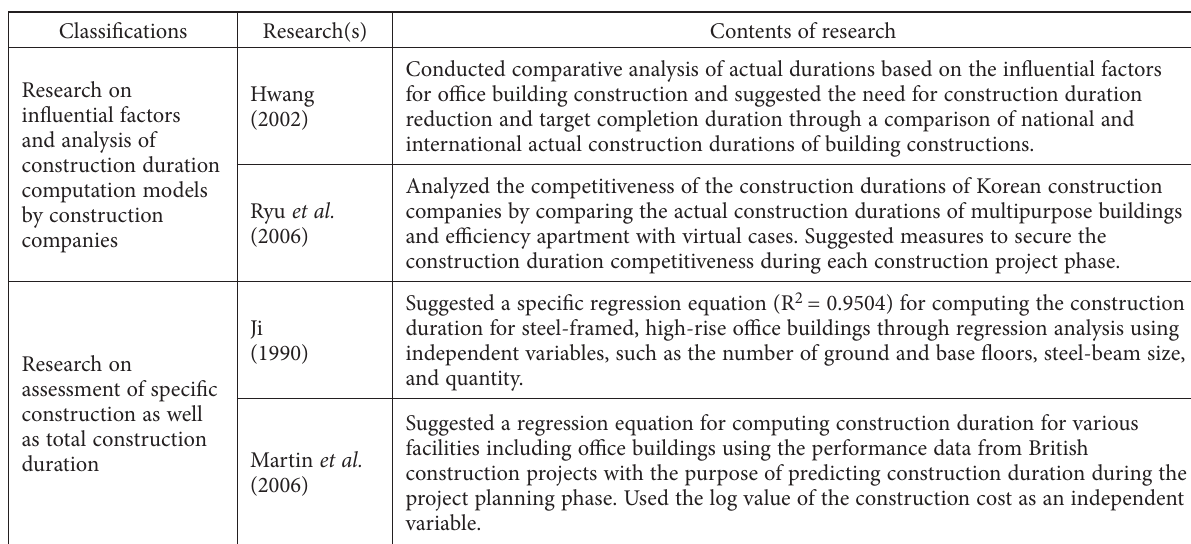
Table 2. Preceding studies on computing the construction duration for general office buildings